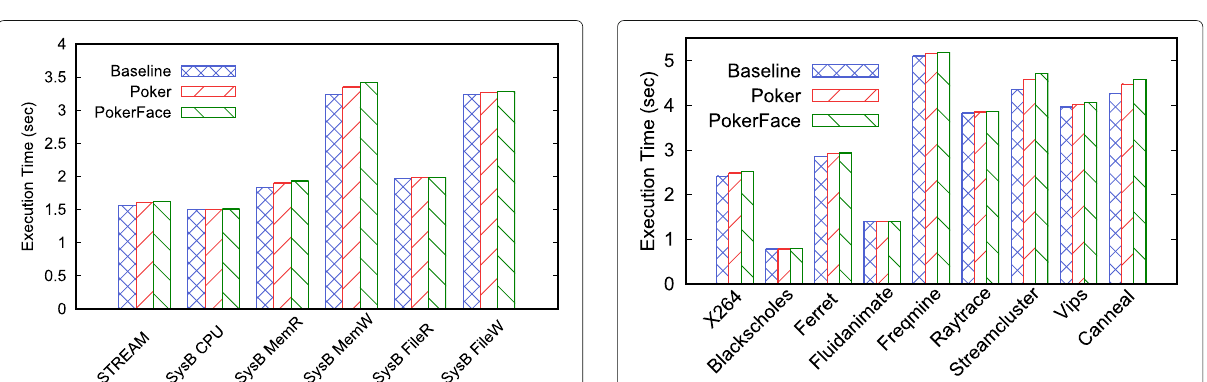
Fig. 6 PokerFace performance overhead on micro benchmarks. The graph shows the overhead incurred by Poker on the Sysbench and STREAM micro benchmarks. These benchmarks represent CPU, memory and file workloads. Since PokerFace essentially operates on the memory subsystem, the memory benchmarks suffer an overhead of up to 7%, of which 4% is due to Poker and always sustained. The additional 3% overhead due to Face occurs only when an attack is suspected and cache obfuscation is triggered. CPU and file